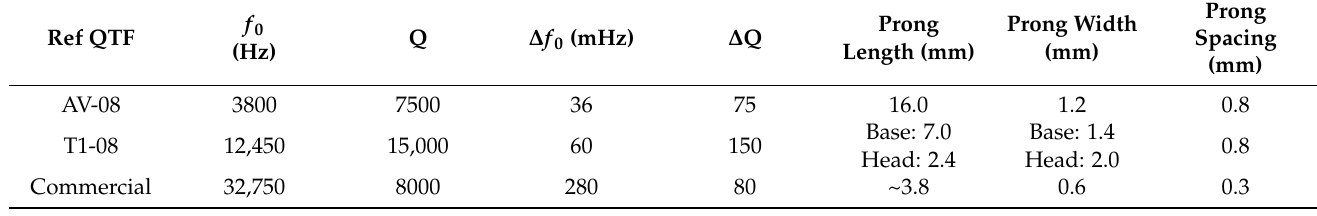
Table 1. Considering a 1% error on the QEPAS signal to be acceptable, the ∆ f 0 and ∆ Q values are calculated for samples AV-08, T1-08 and commercial QTF (NC38LF by Fox Electronics). Measurements are performed on the fundamental mode.